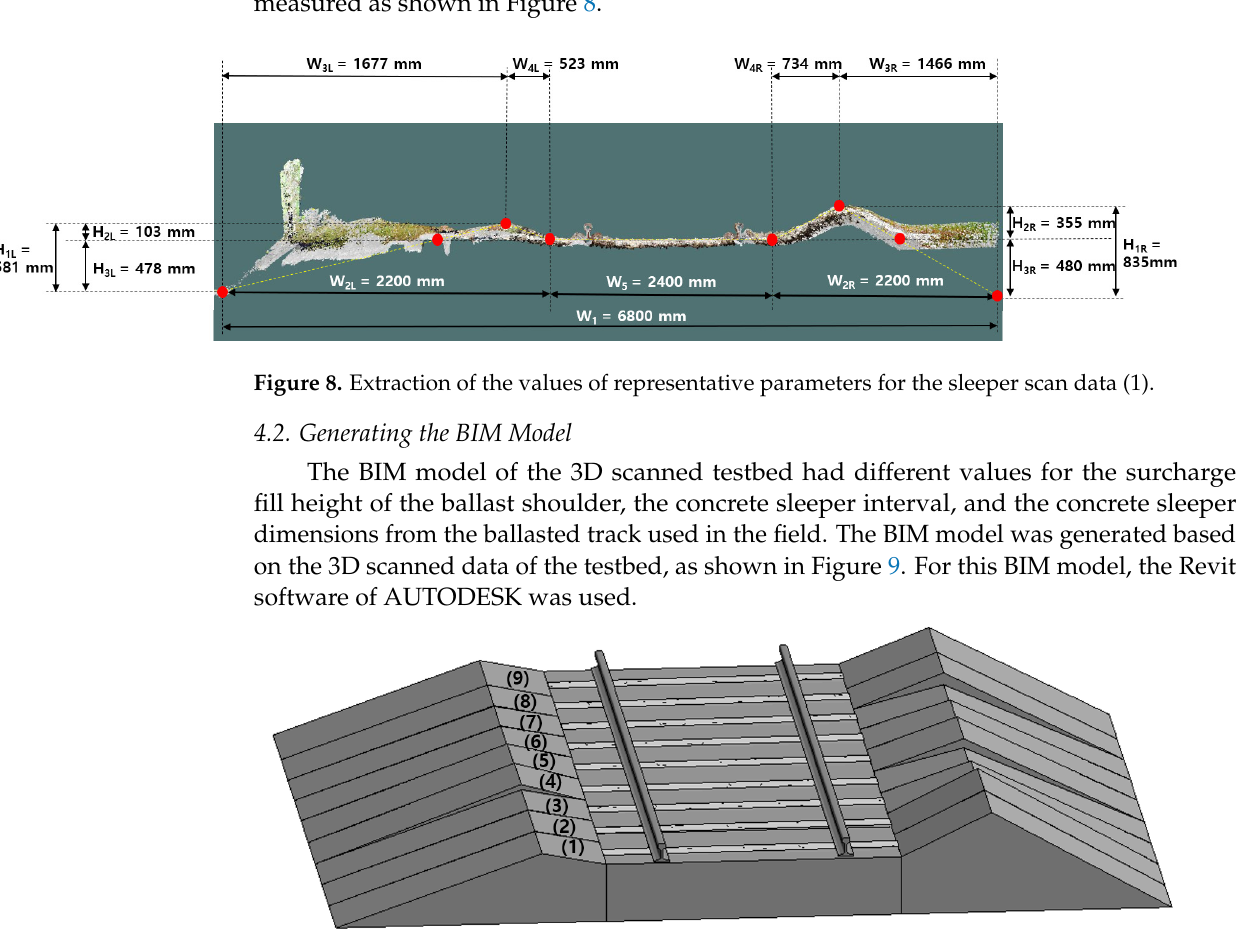
Figure 9. Testbed 3D scanning BIM model.